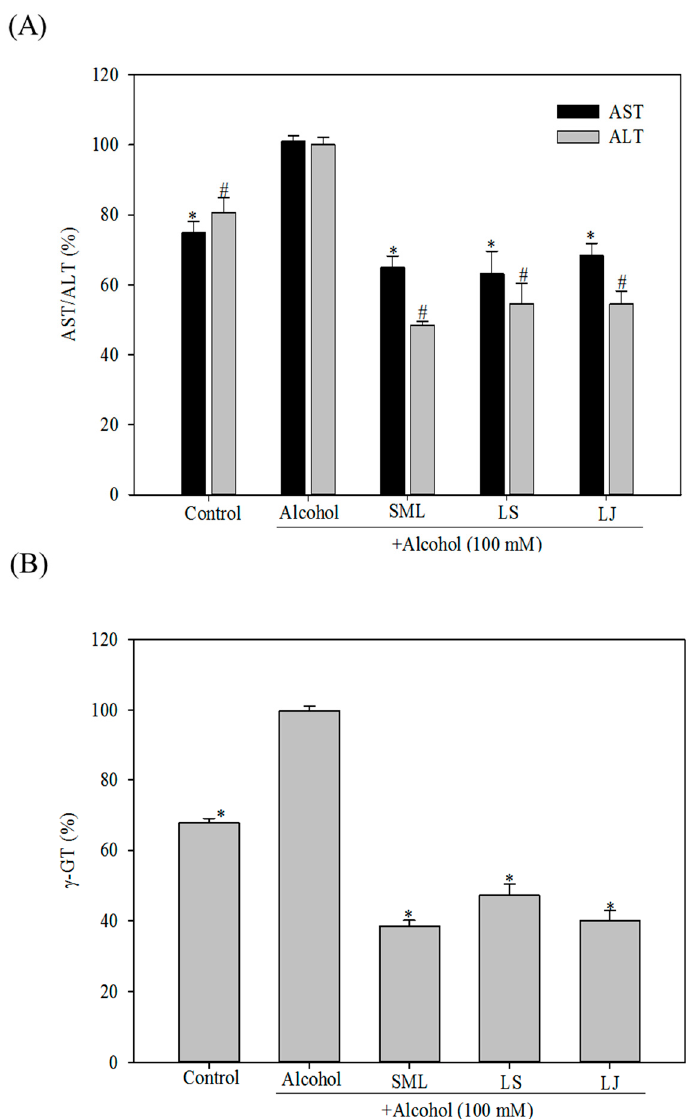
Figure 1. Effects of heat-killed Lactobacillus salivarius (LS), Lactobacillus johnsonii (LJ) and silymarin (SML) on aspartate transaminase (AST) and alanine transaminase (ALT; ( A )); and γ -glutamyl transferase ( γ -GT; ( B )) levels in human HepG2 cells induced by alcohol. Experimental conditions were as described in the Materials and Methods. Bars represent mean ± SD ( n ≥ 3). * p < 0.05 or # p < 0.05 for any alcohol treatment groups and control group versus alcohol group.